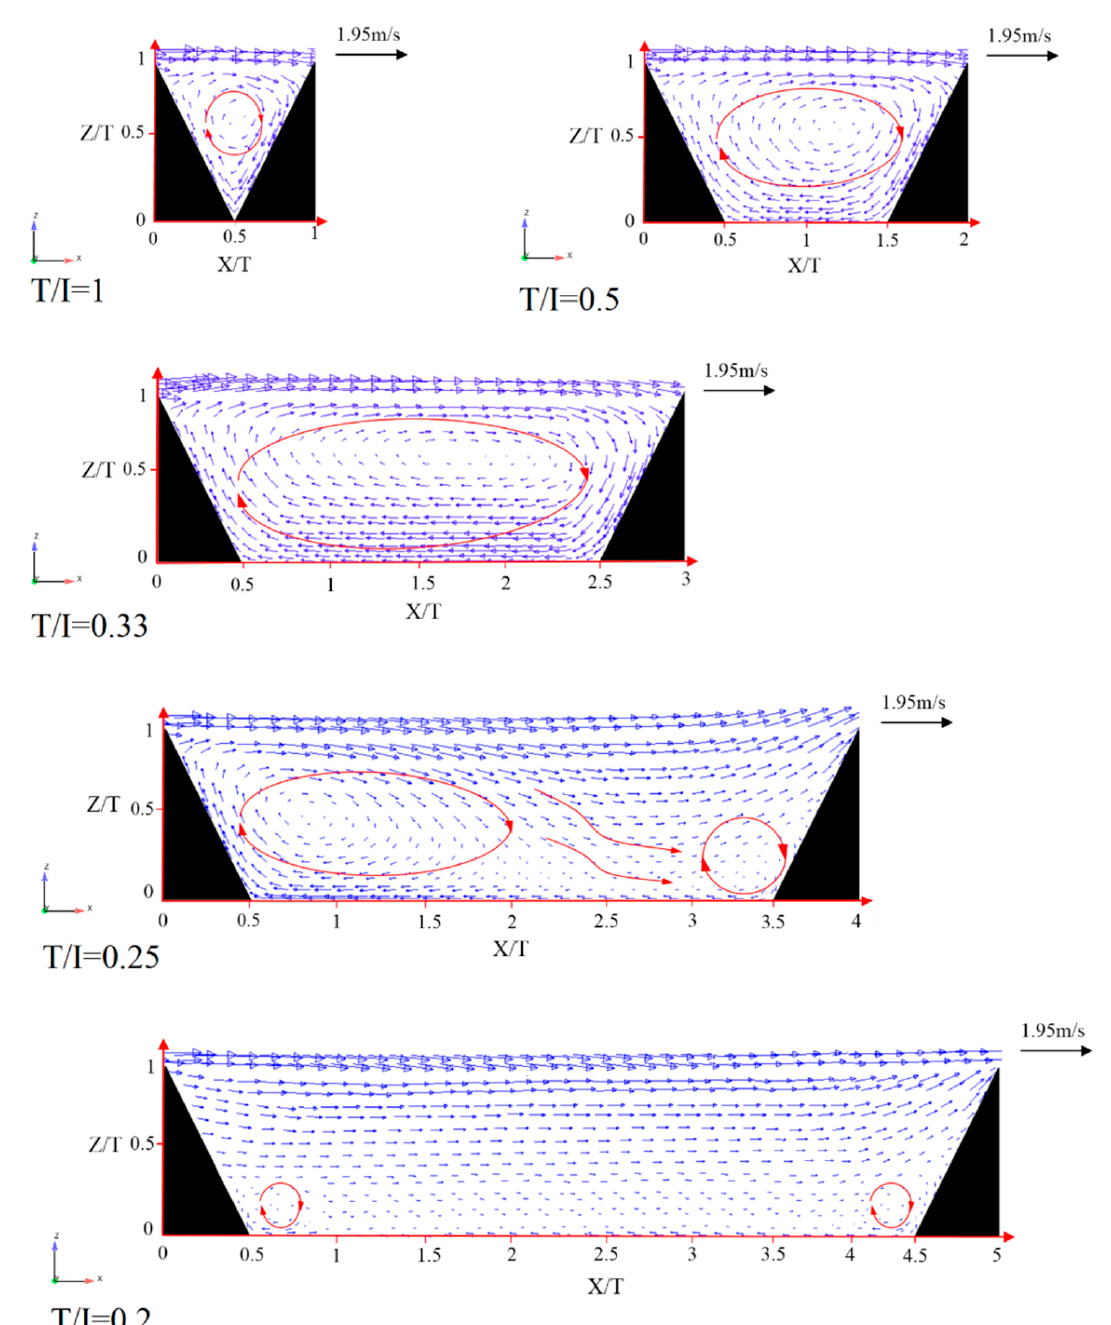
Figure 9. Velocity vector distributions in the x–z plane ( y = 0) within the cavity region.